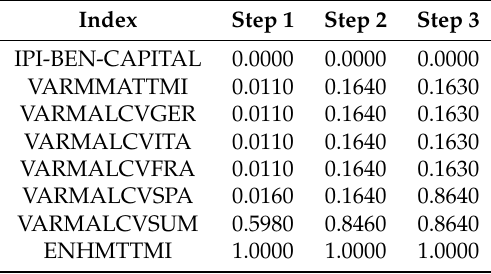
Table A28. Model confidence set hierarchy loss function is squared error at the end of the sample for capital goods model comparison α = 0.05, number of bootstrap replications = 5000 and block length = 12. The null hypothesis is that the average performance of the model in the row is as small as the minimum average performance across the remaining models. The alternative is that the minimum average loss across the remaining models is smaller than the average performance of the model in the